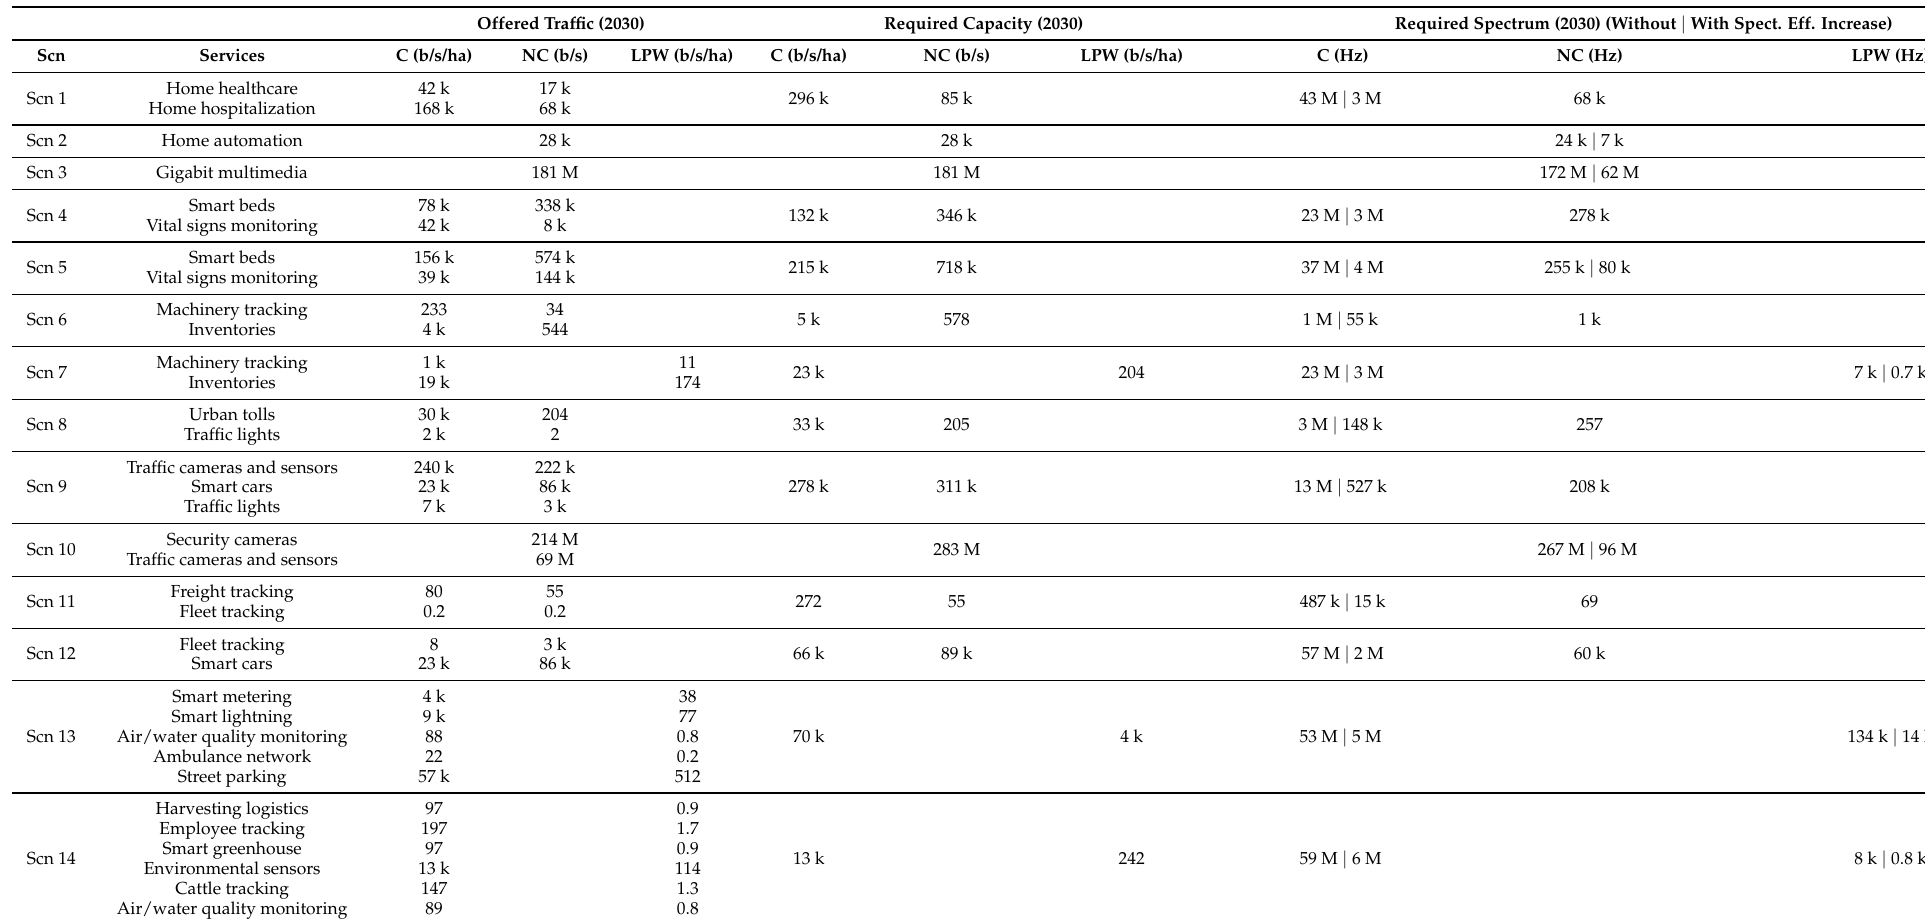
Table 3. Offered traffic, required capacity and required spectrum with and without spectral efficiency and teledensity increase, for Cellular (C), Non-Cellular (NC) and LPWAN (LPW) services, per